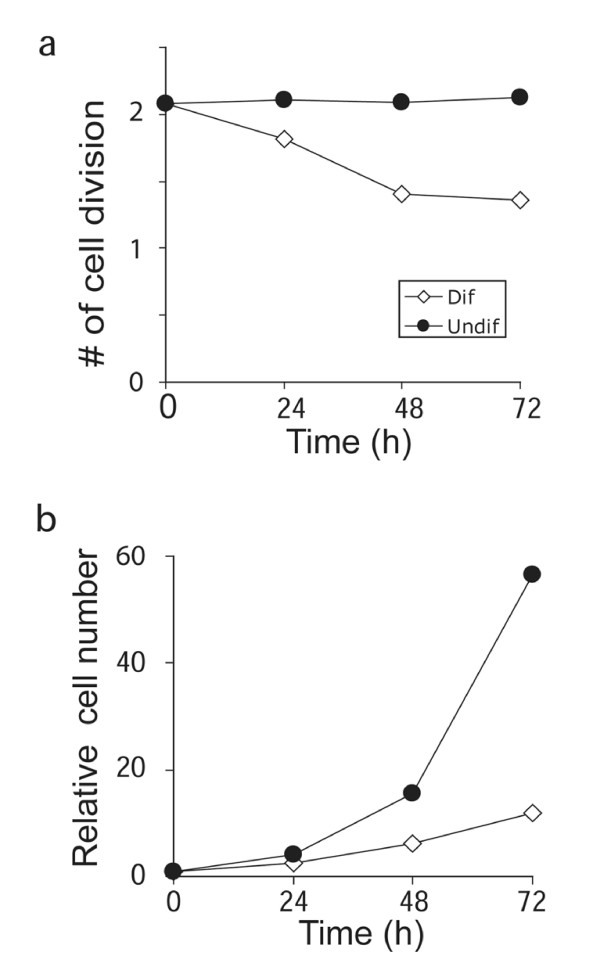
Growth and cell cycle regulation during endothelial differentiation. a) Rate of cell proliferation. RoSH2 cells were labeled with CFDA, a cell-permeable fluorescent dye, and then cultured for 24 hours. They were then plated on gelatin-coated plates under non-differentiating condition or on matrigel-coated plate under differentiating condition. At 0, 24, 48 and 72 after plating, cells were harvested, median cellular fluorescence was measured by flow cytometry and the number of cell divisions was calculated as a function of the loss in fluorescence for every twenty-four hour; b) the cell numbers were counted and normalized against cell count at time 0. Cell number at time 0 was designated as one.